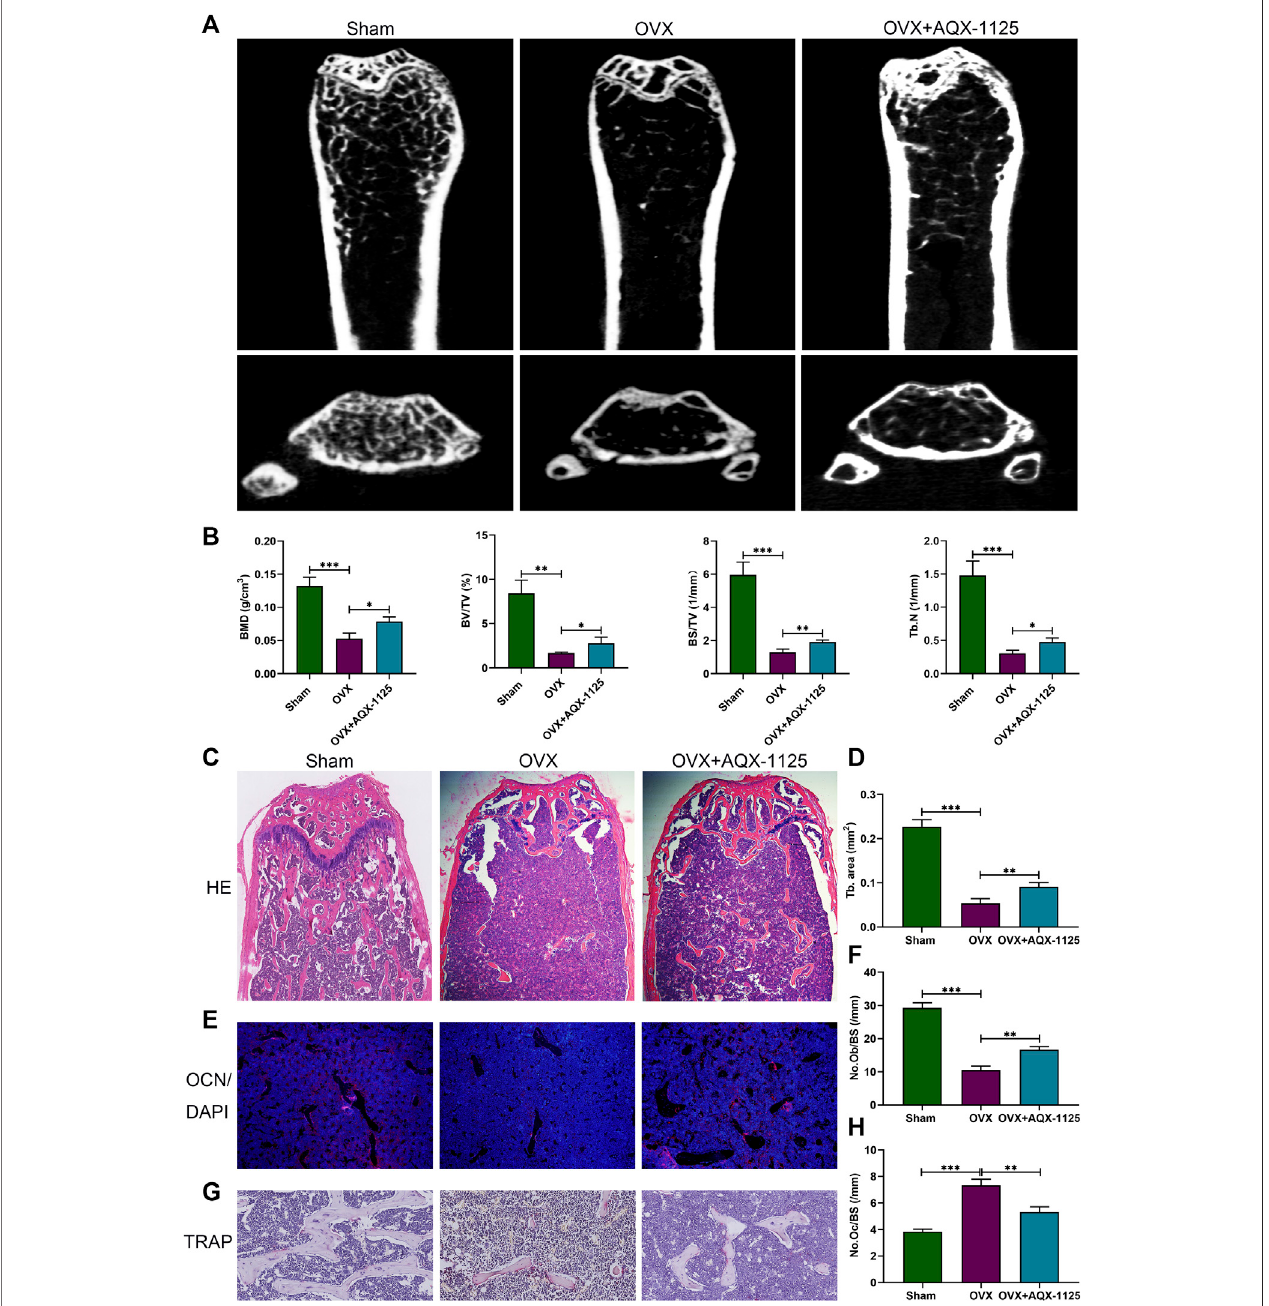
FIGURE1| AQX-1125alleviatesOVX-induced bone loss invivo . (A) Micro-CTanalysisofthedistal femurs from threegroups ( n =3): sham, OVX, and OVX+AQX- 1125 (10 mg/kg/bw). (B) Quantitative analysis of BMD, BV/TV, BS/TV and Tb. N. (C) Representative images of HE staining of the distal femur sections. Scale bars = 200 μ m. (D) Quantitativeanalysisoftrabecular(Tb)boneareain (C) . (E) Representativeimmuno fl uorescenceimagesofOCNinfemursfromdifferentgroups.Blue:DAPI; red:OCN.Scalebars=100 μ m. (F) Quanti fi cationoftheosteoblastnumberin (E) . (G) RepresentativeimagesoffemursstainedwithTRAP.Scalebars=50 μ m. (H) Histomorphometric analysis of the osteoclast number in (G) . Data are presented as means ± SD from three independent experiments (* p < 0.05; ** p < 0.01; and *** p < 0.001).